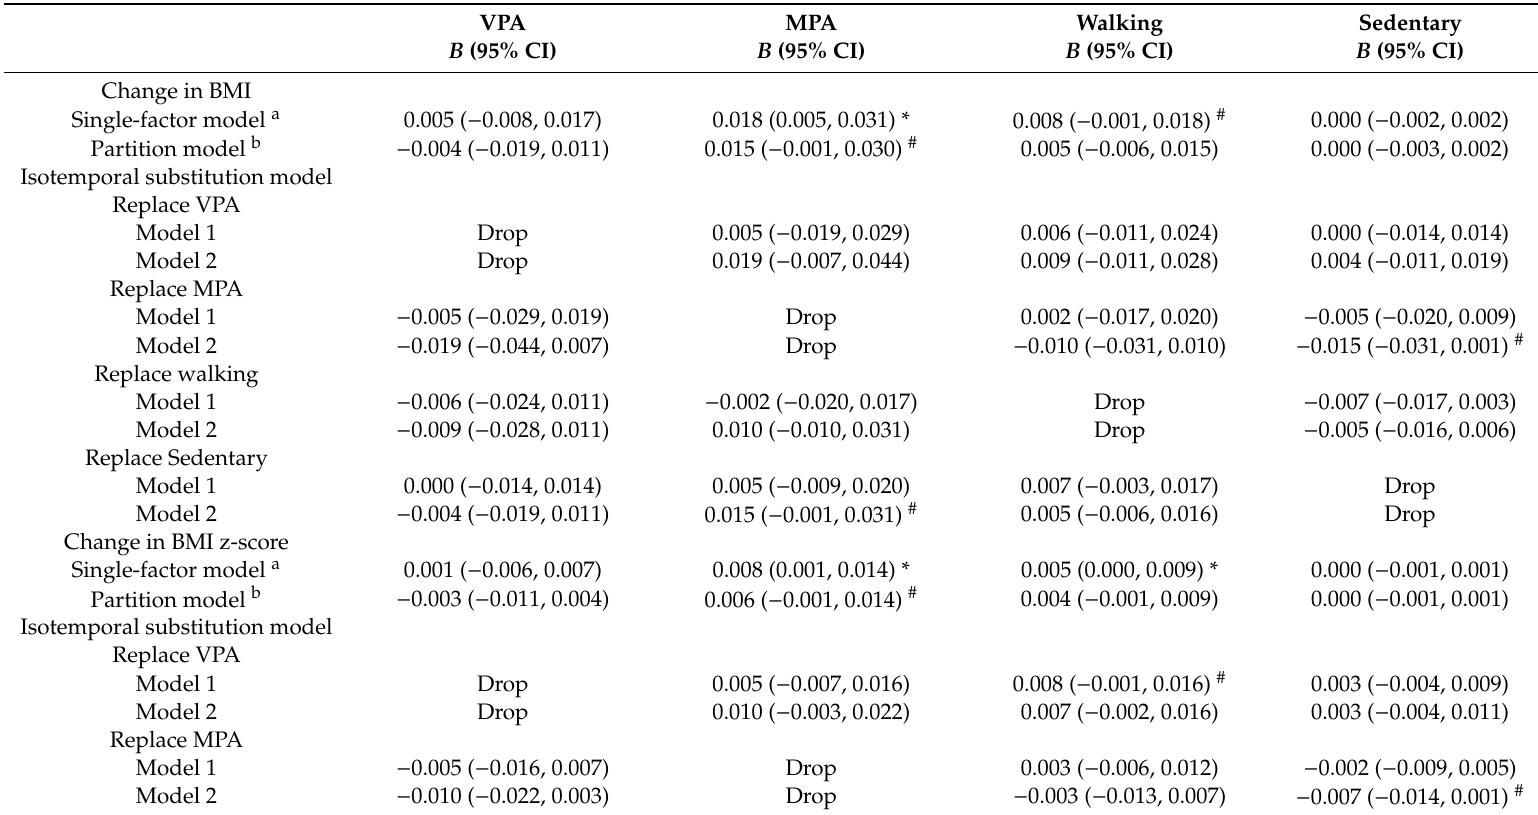
Table 4. Single-factor, partition, and isotemporal substitution models of association between 30 min / d change in di ff erent intensity categories and changes in BMI and BMI